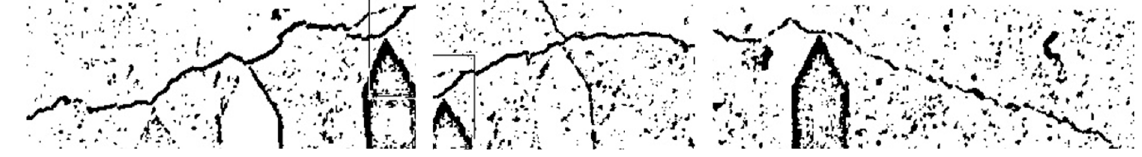
Figure 17. Sauvola local thresholding outcome.